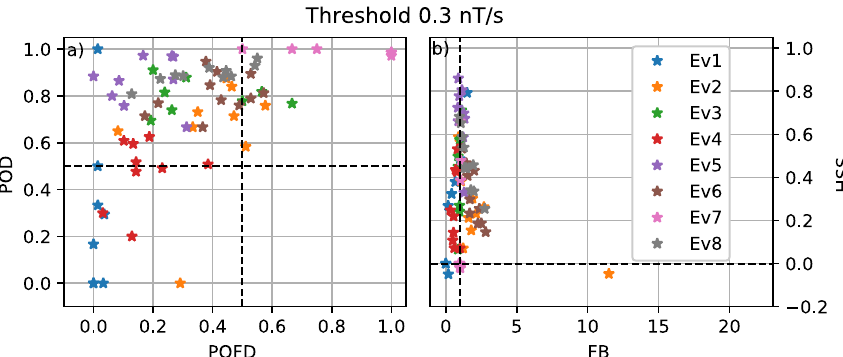
Fig. 8. Panel a shows the probability of detection (POD) versus probability of false detection (POFD). The horizontal line in panel a) marks POD = 0.5 while the vertical line marks POFD = 0.5. Panel b shows the Heidke skill score (HSS) versus model frequency bias (FB). The horizontal line shows no skill score, HSS = 0 while the vertical line marks the perfect score for frequency bias, FB = 1.